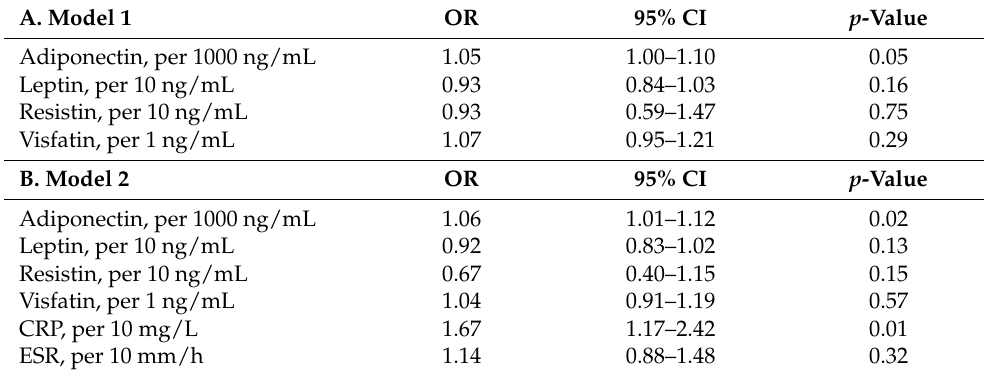
Table 3. Multivariable conditional logistic regression analysis for RA in the nested case-control cohort from the SOS